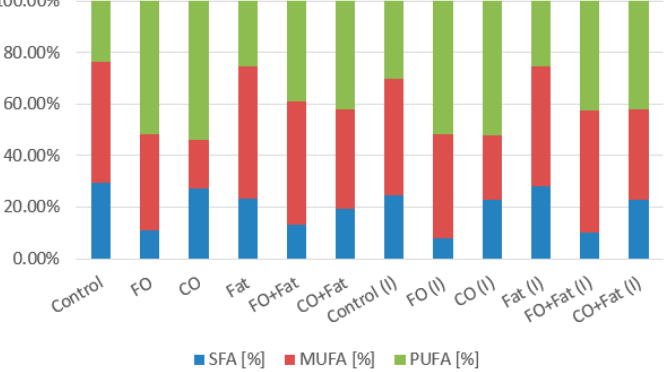
Figure 5. Phase II: Fatty acid production of Rhodotorula kratochvilovae cultivated on waste lipid media with and without lipase